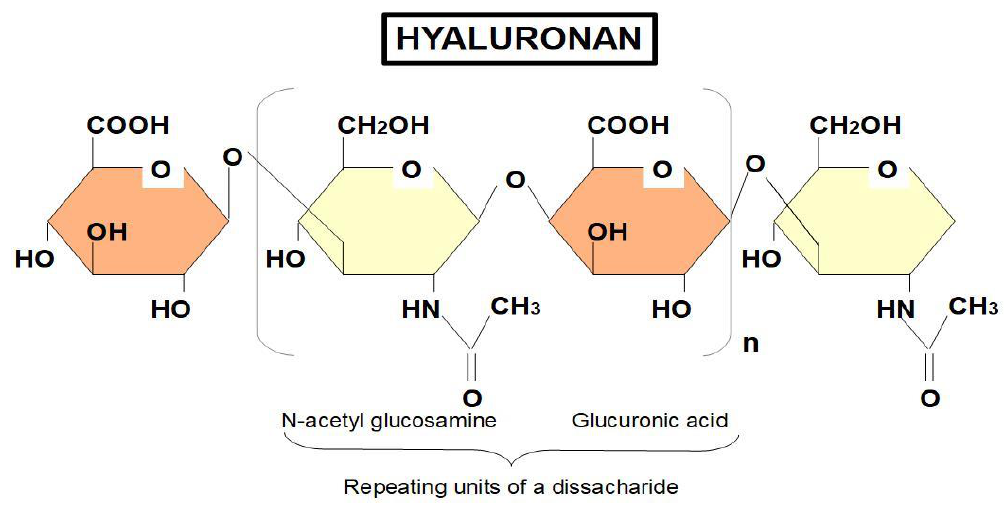
Figure 2. Chemical structure of hyaluronan.